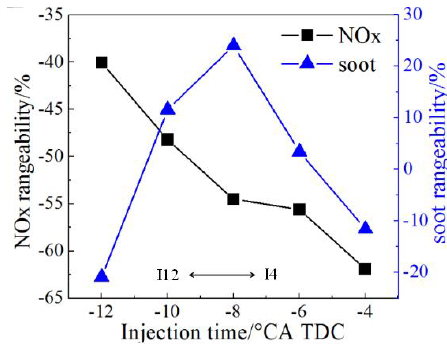
Figure 15. Influence of injection time of high ε Miller cycle on NO x and